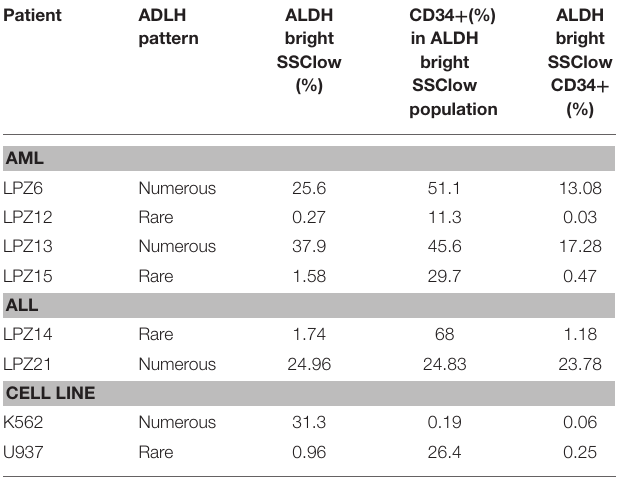
TABLE 3 | LSC proportion in leukemic samples based on ALDH activity.